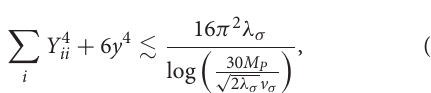
FIGURE 4 | Confidence level (C.L.) contours (95% C. L.) of the parameters in the scalar potential (30), as a function of the non-minimal coupling parameter ξ yielding inflation constrained by Planck 2015 observations at the pivot scale 0.05 Mpc − 1 [taken and used with permission from Ballesteros et al. (2017b)]. (Upper left) The canonical inflaton value χ I . (Upper right) The value of the quartic coupling. (Lower left) The predicted tensor-to-scalar ratio. (Lower right) The running of the spectral index. The best fit for a given ξ σ is drawn as a thin black line, while the minimum and maximum values of n s are drawn as red and blue curves, respectively, corresponding to a redder or bluer primordial spectrum of curvature perturbations. The thicker black line displays the predictions when accounting for the HHSI prediction of a universe expanding, immediately after inflation, according to the equation of state of radiation domination. The region ξ σ > 1, where perturbative unitarity fails in SMASH, is